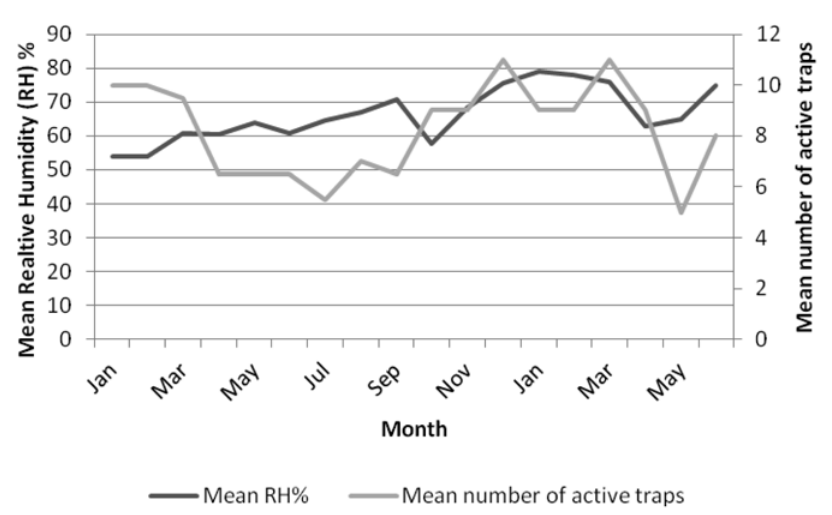
Fig. 4. Mean number of active collection traps (out of 22 total) at the C. formosanus field site in comparison to mean relative humidity from January 2010 –June 2011.